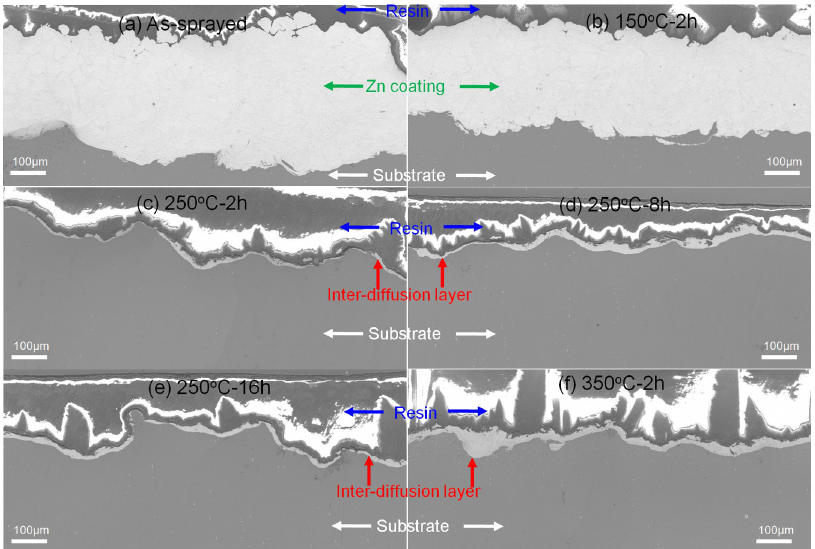
Figure 7. Cross-sectional microstructures of fractured surfaces of Zn coatings after different heating conditions.